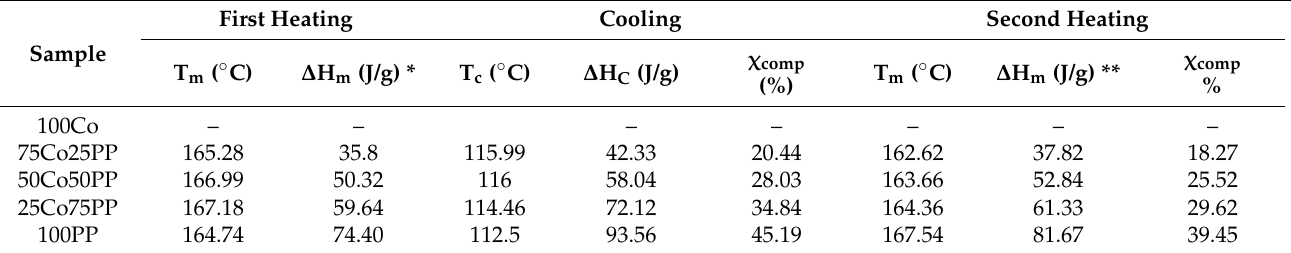
Table 4. DSC data of biocomposite